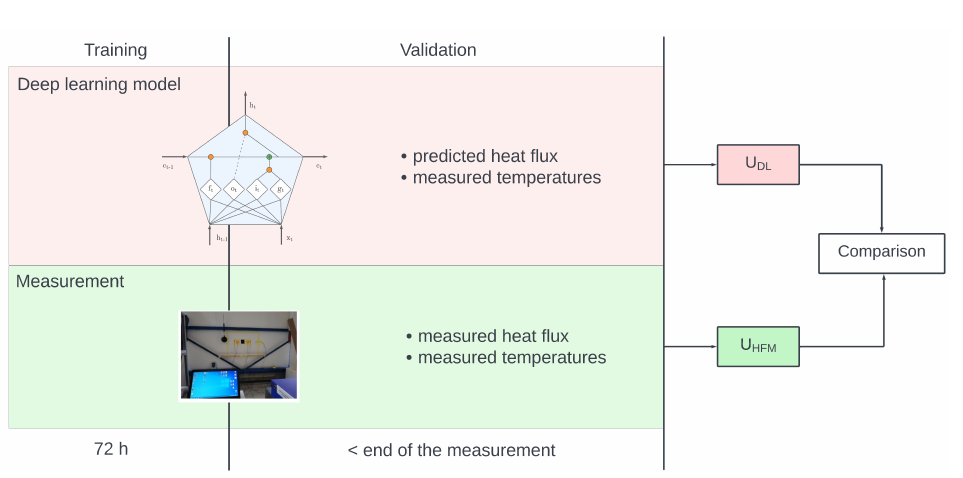
Figure 4. Research